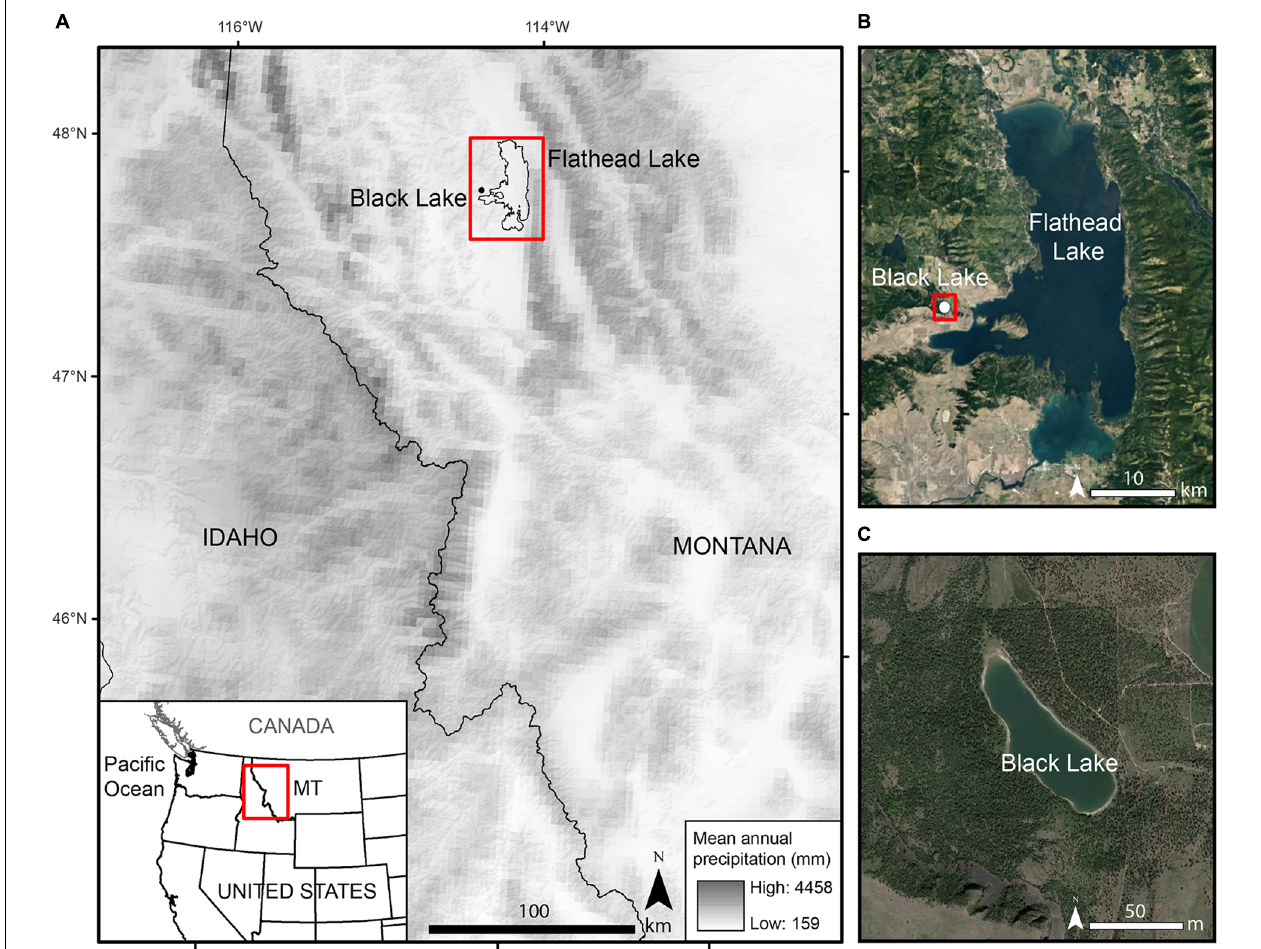
FIGURE 1 | (A) Location of Black Lake in the Northern Rocky Mountains over a base map showing the mean annual precipitation from 1981 to 2010 (PRISM Climate Group, 2015; map source: ESRI). (B) Location of Black Lake in Lake County, MT (map source, Google Earth). (C) Close up of Black Lake (map source, Google